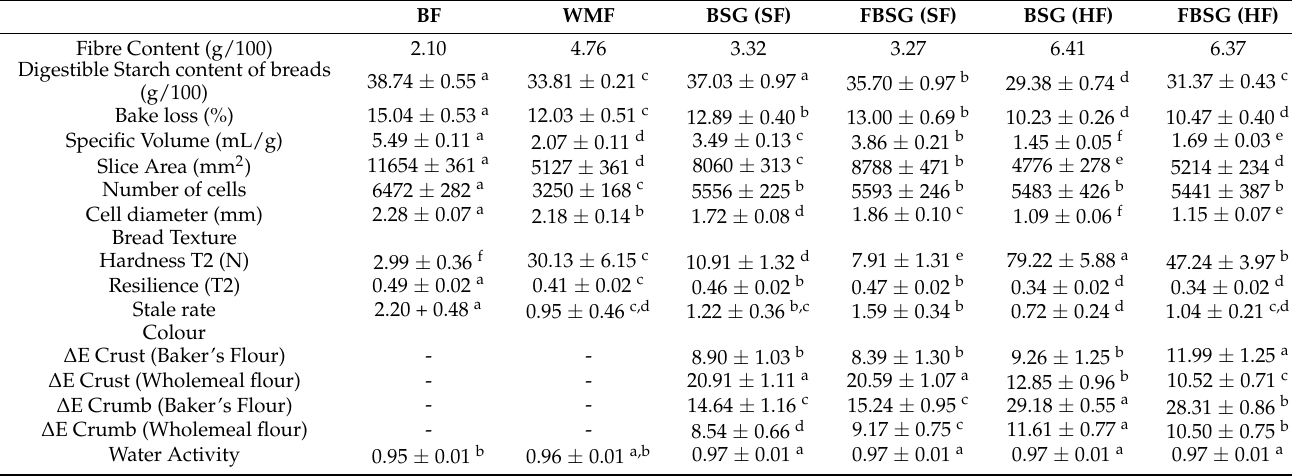
Table 4. Results from analysis of the techno-functional properties of bread with inclusion of brewers’ spent grain (BSG) and fermented brewers’ spent grain (FBSG) at source of fibre (SF) and high in fibre (HF) addition levels. BF and WMF represents results obtained from baker’s flour and wholemeal flour breads, respectively. The values shown represent the mean ± the standard deviation. Values which have the same letter in the same row do not differ